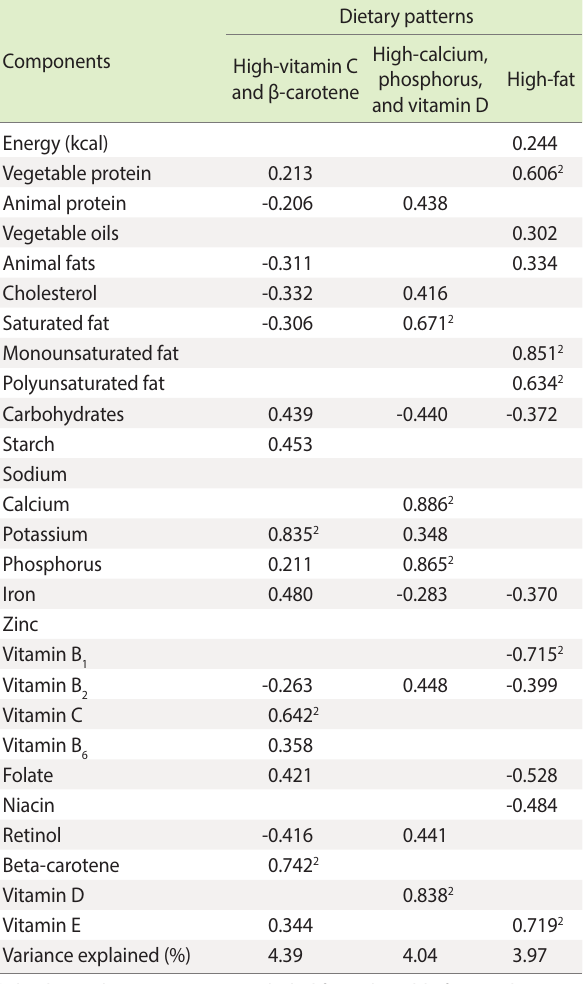
Table 2. Factor loading matrix for the 3 major dietary patterns iden- tified in the study sample